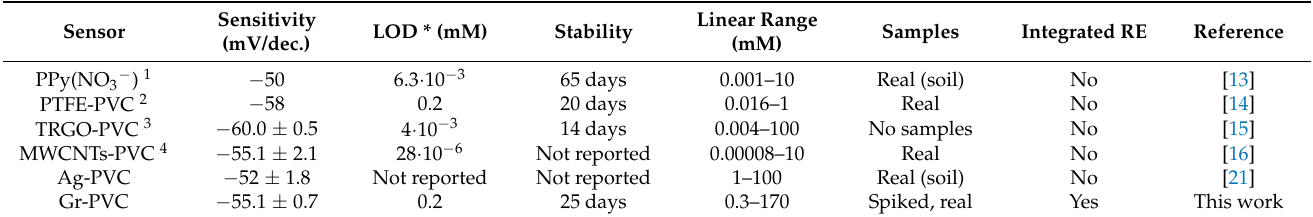
Table 1. Comparison between several reported sensors in the bibliography and the one presented in this